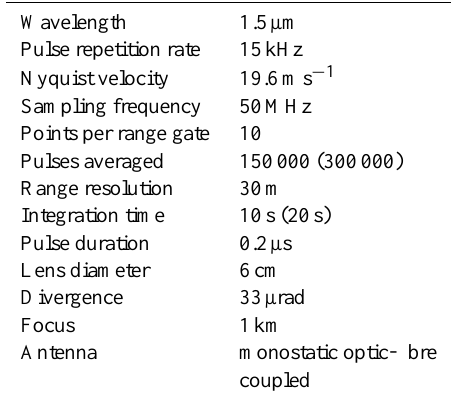
Table 1. Doppler lidar operating parameters for the vertical stare mode during the deployment at Mace Head. System parameters for an individual radial measurement in the DBS mode, where different, are given in